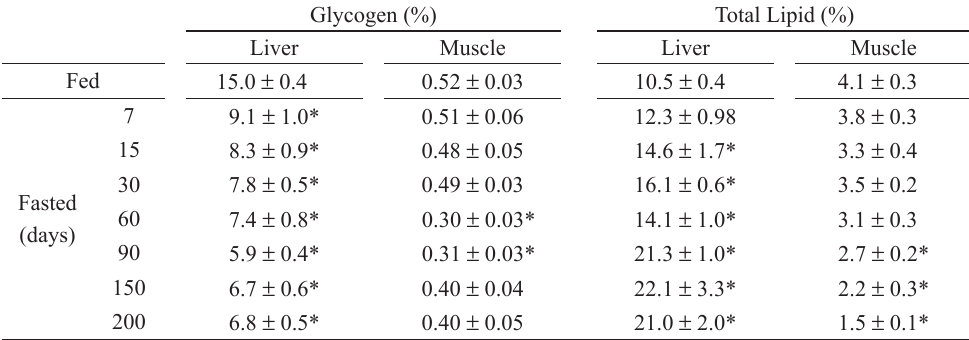
Liver and muscle glycogen and total lipids of fed and fasted red tilapias.